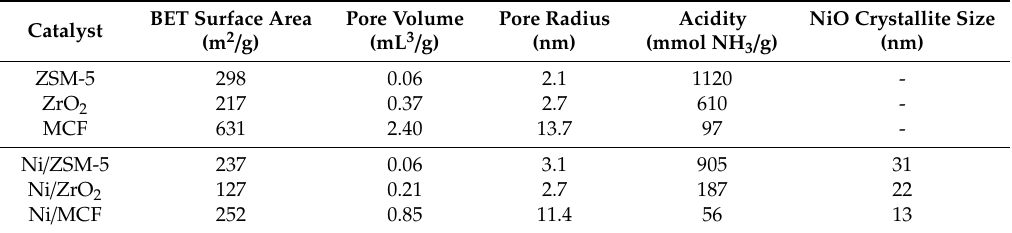
Table 3. Selected physicochemical properties of the supports and Ni catalysts.